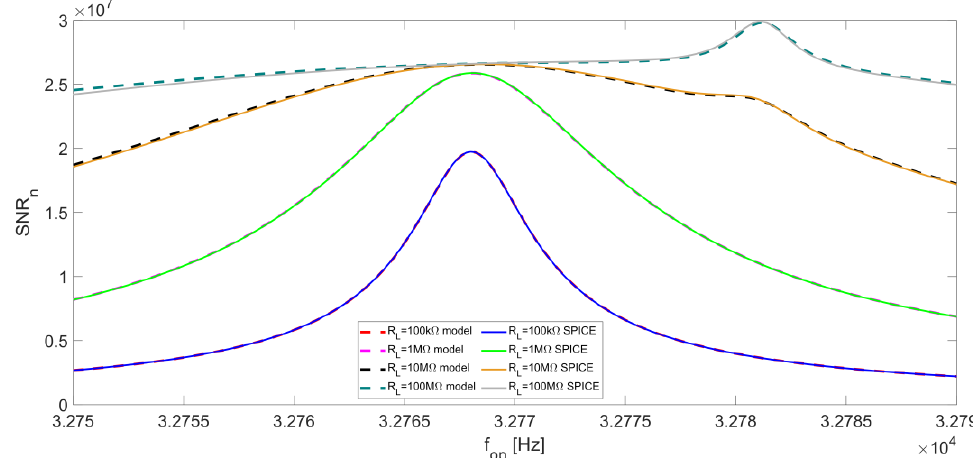
Figure 16. Total normalized signal-to-noise ratio SNR n at the LIA output as a function of the operating frequency, for different values of R L and at a low-pass filter bandwidth of BW = 0.5 Hz. The corresponding results of SPICE simulations are also reported.